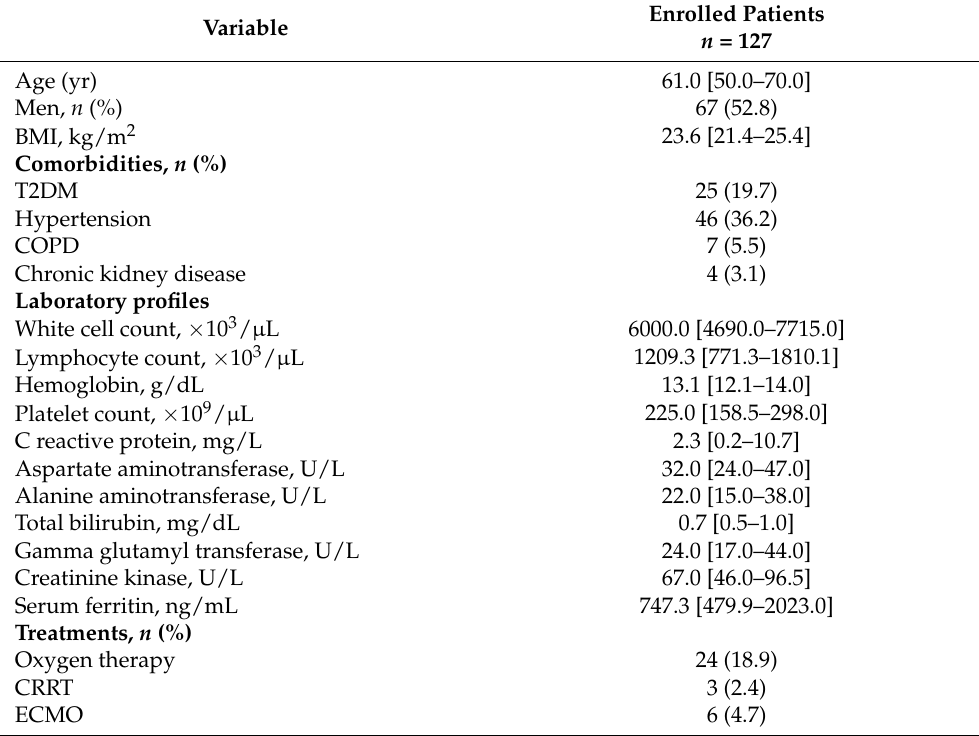
Table 1. Baseline characteristics of enrolled